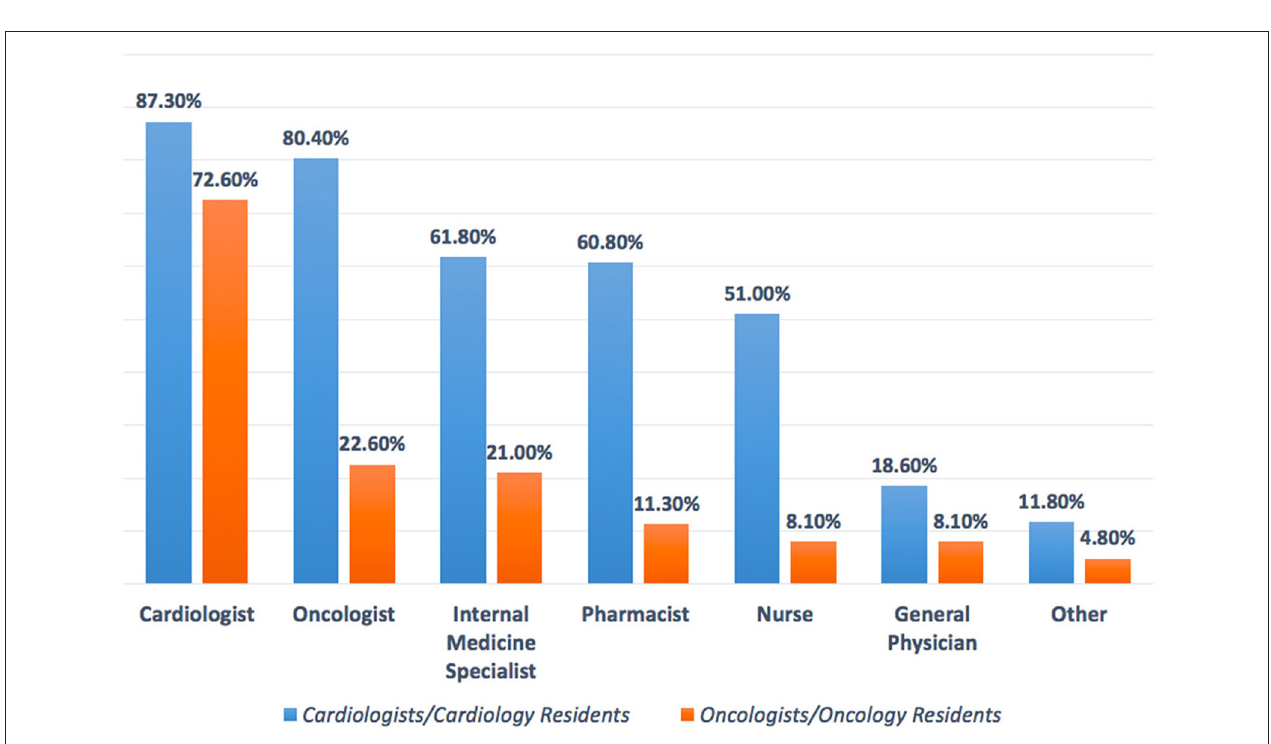
FIGURE 8 | Suggest cardio-oncology team members. Cardiologists, oncologists, internal medicine specialists, and pharmacists are the main specialists in the cardio-oncology team. Oncologists/oncology residents tend to focus mainly on cardiologists as a member of the cardio-oncology team.